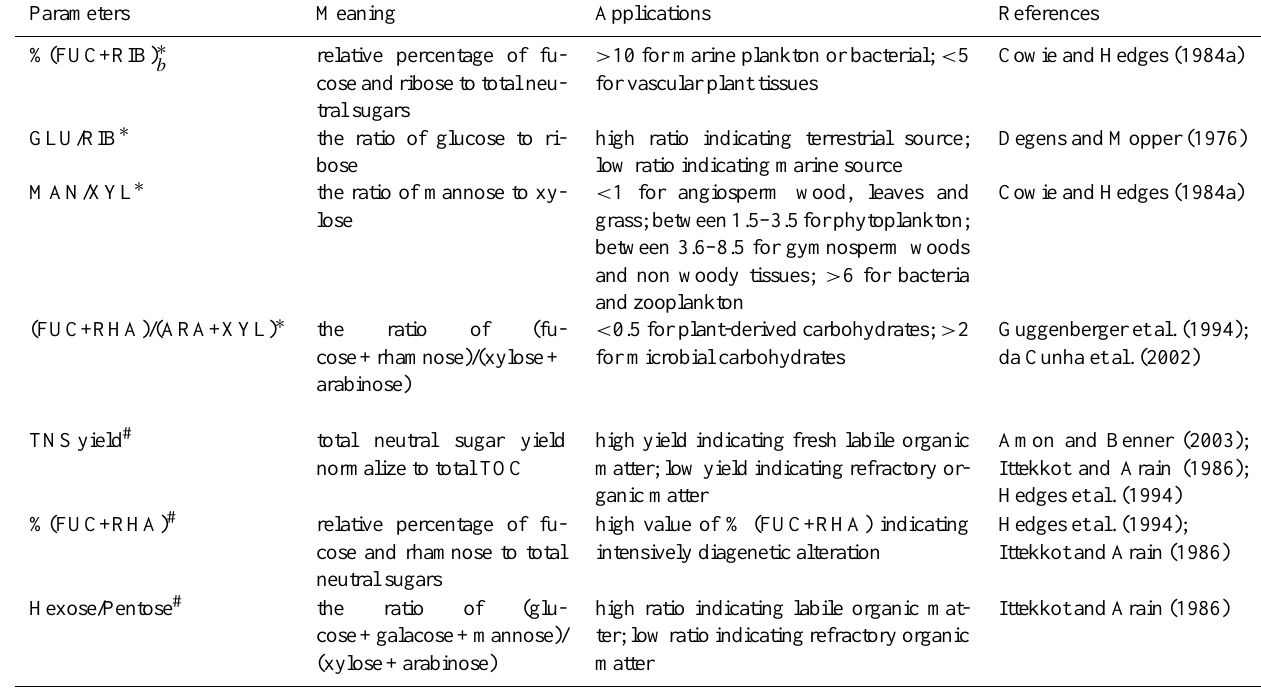
Table 1. Summary of carbohydrate composition and the neutral sugar ratio as indicators of organic matter sources and diagenetic state in natural